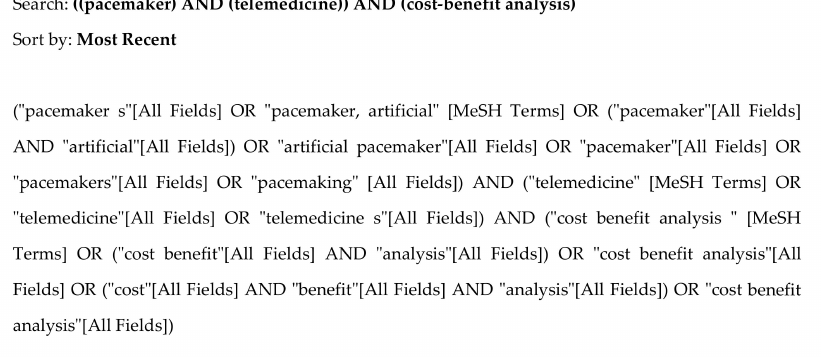
Figure 1. Search strategy used in MEDLINE (via